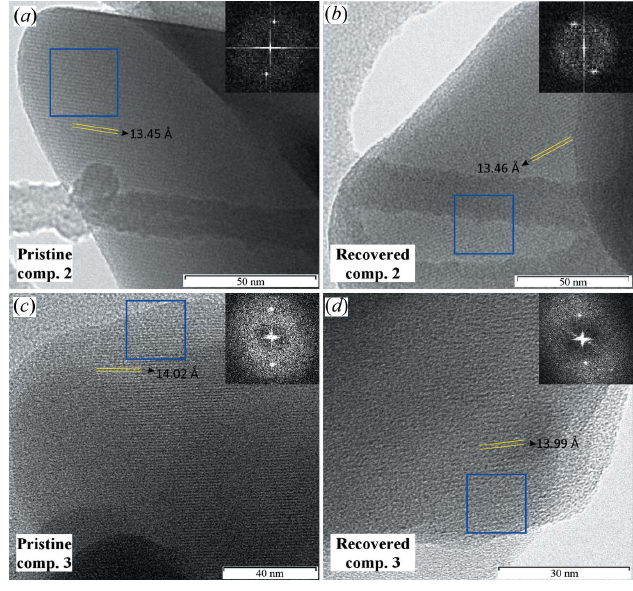
Figure 10 HRTEM images for pristine compounds ( a ) 2 and ( c ) 3 and the recovered residues after the catalytic reactions for ( b ) 2 and ( d ) 3 . Lattice spacing is marked by yellow lines and the upper right image corresponds to the Fourier transform of the area inside the blue square.